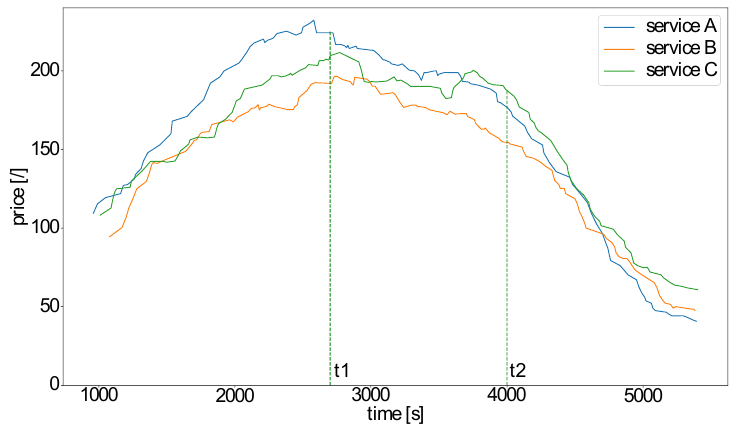
Figure 5. Price of services over time.